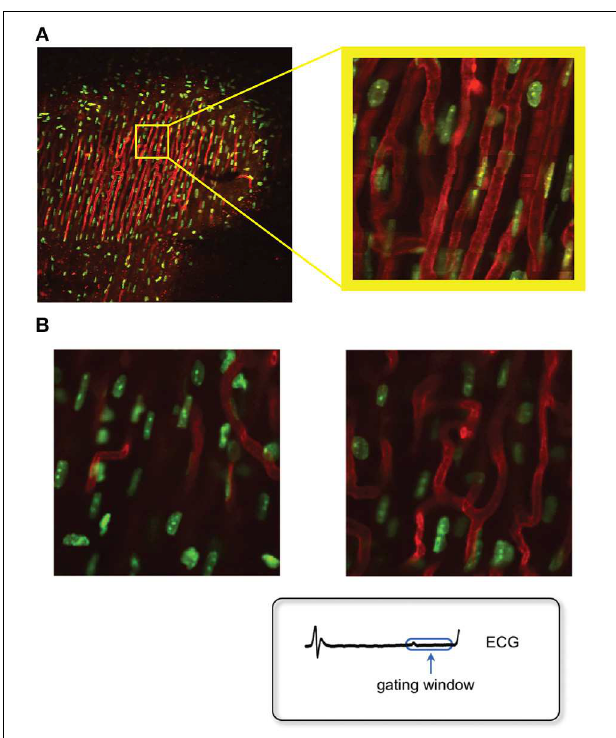
FIGURE 13 | Fluorescence images of the myocyte’s nuclei and the microvasculature as measured in the beating heart in vivo , after motion artifact removal. (A) Sequential segmented microscopy (SSM) allows for stabilized heart imaging enabling both large and small field of view imaging. Green: fluorescent Hoechst 33258 for nuclei staining; red: fluorescent lectin for staining of the myocardium capillaries. Adapted from Vinegoni et al. (2013) . (B) High resolution stabilized images of the myocytes nuclei at different depths within the cardiac muscle can be obtained by optical sectioning. At high resolution imaging, both subcellular and subnuclear structures can be clearly resolved. Adapted from Lee et al. (2012a).